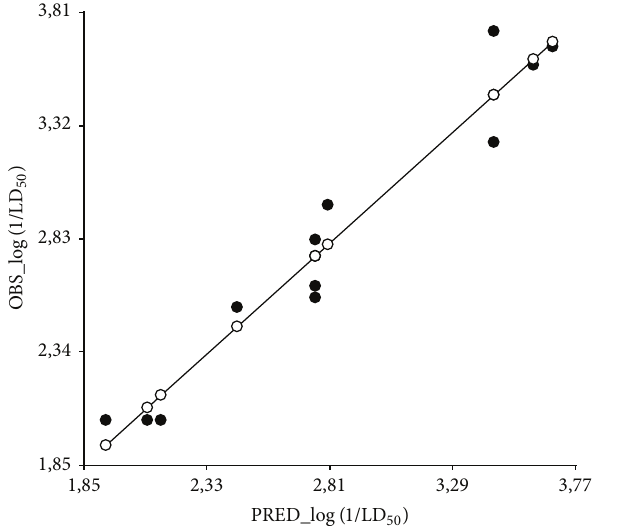
Figure 6: Multiple linear regression analysis (MLR) calculated to examine quantitative relationships between linear combinations of the dependent variable log (1/LD 50 ) and the predictor variables (structure and molecular properties). Plot of calculated versus experimental log (1/LD 50 ) of insecticidal activity of alcohol and phenol compounds against cockroaches.